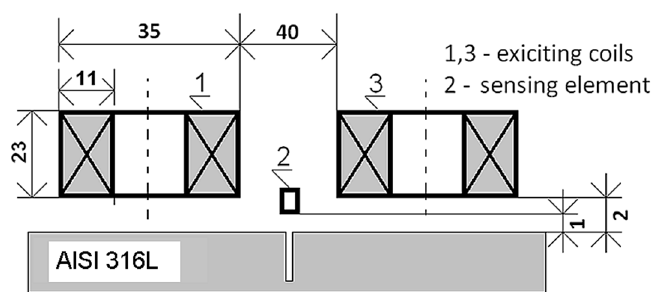
Figure 5. Arrangement of the eddy current testing (ECT) probe over a specimen (dimensions are in mm).